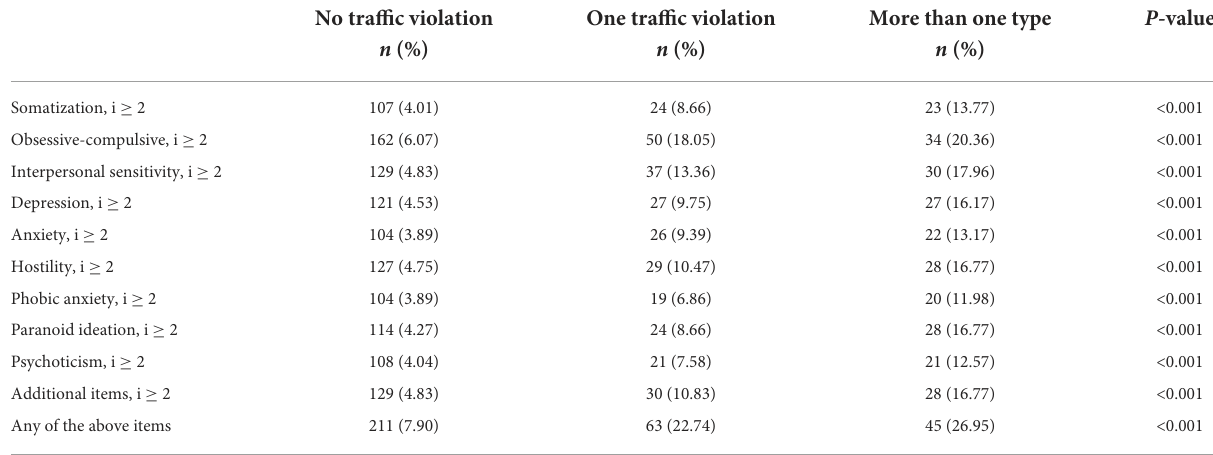
TABLE 4 Prevalence of each psychological symptom among drivers with different types of traffic